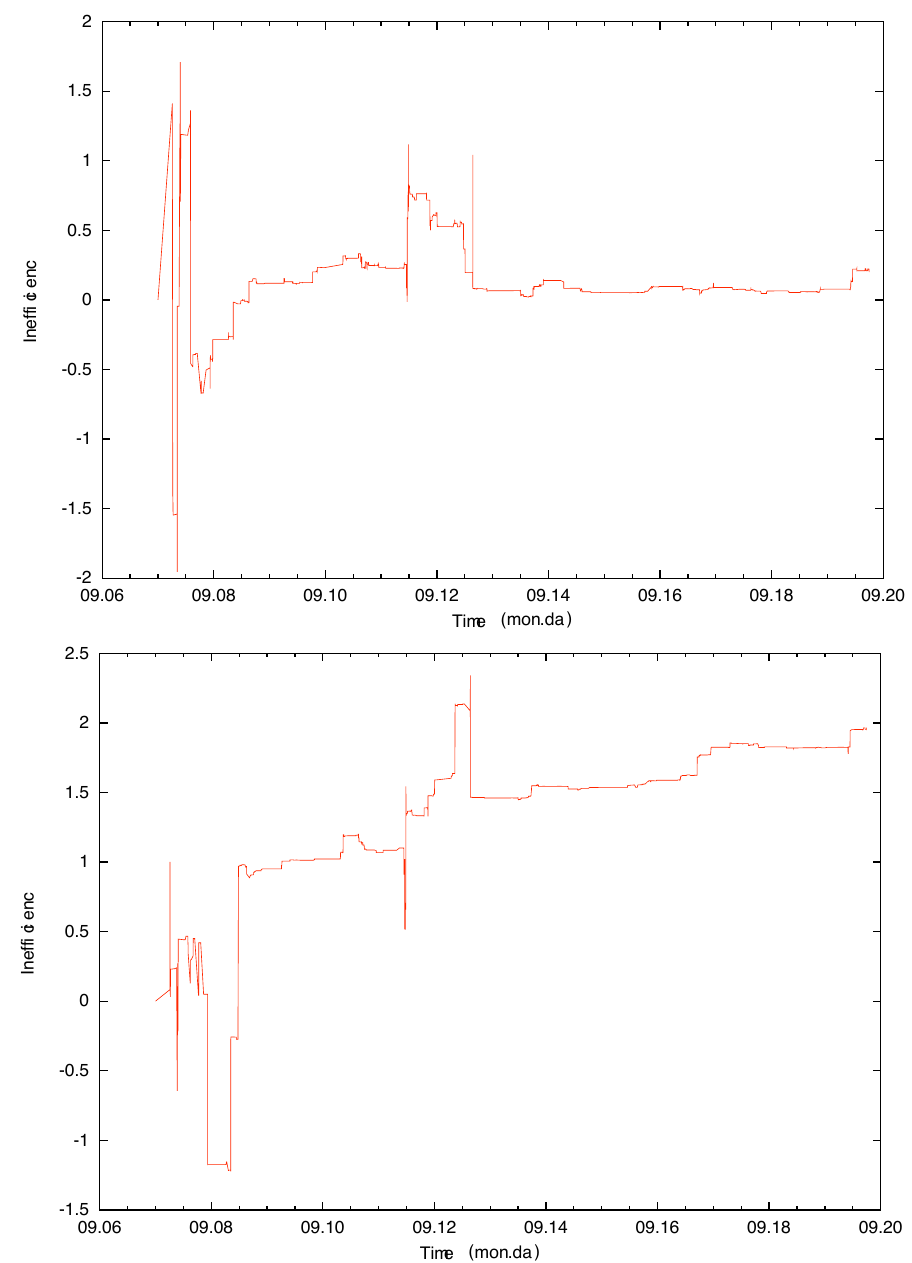
Figure 4. Inefficiency I ij ( t ,0 ) for two agent groups in the out-of-sample (second half) set. On the ( top ), two randomly chosen groups and on the ( bottom ) the decile of agents with the highest ETR against the rest of the